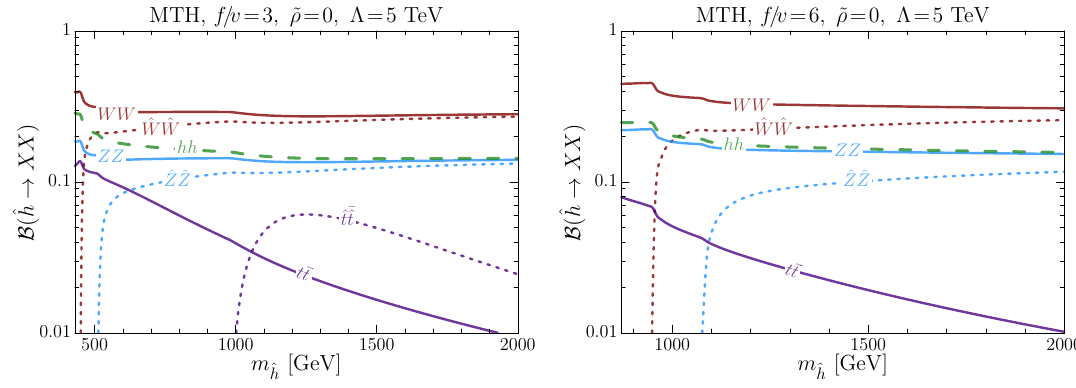
Figure 3 . These plots show heavy twin Higgs branching ratios in the MTH to di(cid:11)erent (cid:12)nal states as a function of its mass. We take f=v = 3 (left-panel) and 6 (right-panel) for ~ (cid:26) = 0 and (cid:3) = 5 TeV. mass 125 GeV. For a given production mode (e.g. gluon fusion), the relative magnitudes of these branching ratios determine the relative rates for the various (cid:12)nal states. In